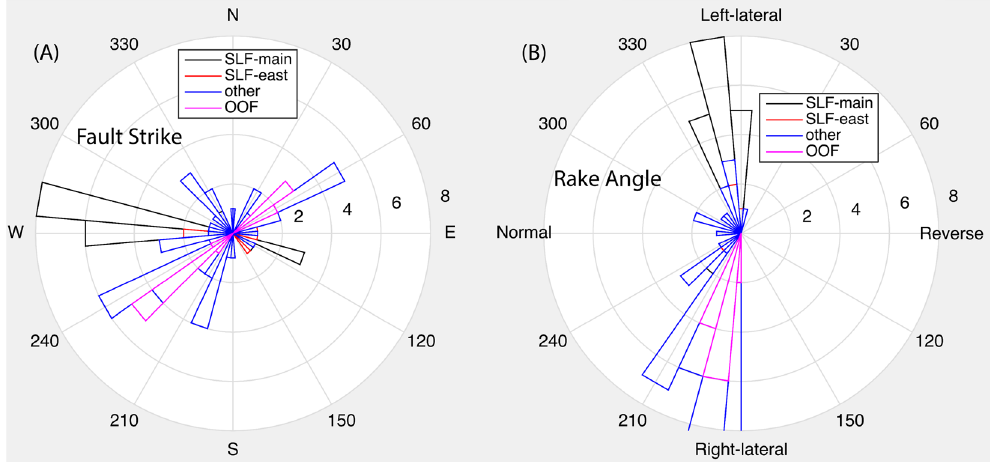
Figure 8. ( A ) Rose diagram of strike angles of nodal planes for individual earthquakes.For events on SLF- main and SLF-east, left-lateral nodal planes are selected. For events on the OOF, right-lateral nodal planes are selected. For other events, no preference is chosen. ( B ) Rose diagram of rake angles for the same set of earthquakes, which suggests a transtensional